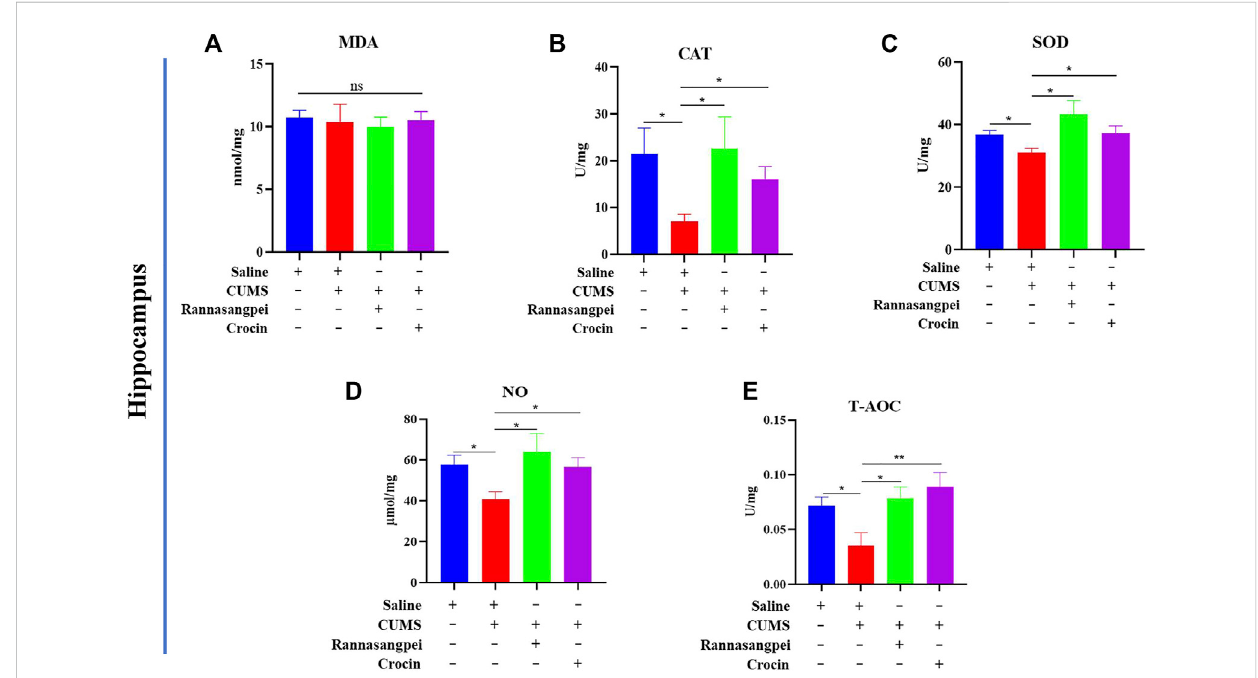
FIGURE 3 RSNP and crocin-1 restored oxidative stress marker levels in hippocampus of CUMS-treated mice (A) Hippocampal MDA levels did not show signi fi cant differences among groups. RSNP and crocin-1 signi fi cantly increased hippocampal CAT (B) , SOD (C) , NO (D) and T-AOC (E) activities or levels intheCUMS-treatedmice.SOD,superoxidedismutase;MDA,malondialdehyde;CAT,catalase;NO,nitricoxide;T-AOC,totalantioxidantcapacity;RSNP, rannasangpei; CUMS, chronic unpredictable mild stress. N = 7. For ANOVA statistics: (A) , F (3,28) = 0.1201, p = 0.947; (B) , F (3,28) = 3.39, p = 0.042; (C) , F (3,28) = 3.425, p = 0.033; (D) , F (3,28) = 4.523, p = 0.017; (E) , F (3,28) = 4.604, p = 0.011.* p < 0.05, ** p < 0.01, *** p <